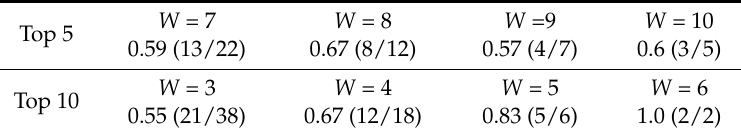
Table 2. The precision of the entrances to pills in Nikkei